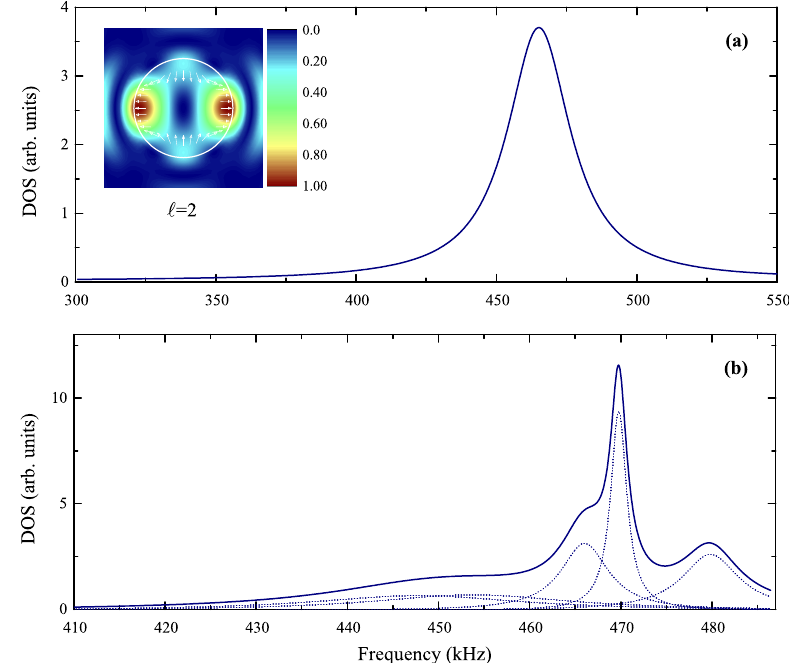
Figure 6. ( a ) calculated difference in the density-of-states of the elastic field for a D5N35 sphere (diameter d = 5 mm) immersed in water, with respect to the infinitely extended host medium (water), revealing an (cid:96) = 2 five-fold resonant mode. In the inset, we give, after extraction of the incident component, the color map of the modulus of the elastic field at resonance ( f = 467 kHz), in a plane passing at the center of the sphere (incidence is assumed along the horizontal axis directed from left to right); the white arrows show the direction of the elastic field; and ( b ) calculated difference in the density-of-states of the elastic field for a square array of touching D5N35 spheres (diameter d = 5 mm) immersed in water, with respect to the infinitely extended host medium (water) for ( 0.35,0 ) , revealing the splitting of the (cid:96) = 2 five-fold resonant modes of the individual sphere k (cid:107) = 2 π a to five non-degenerate modes (dotted